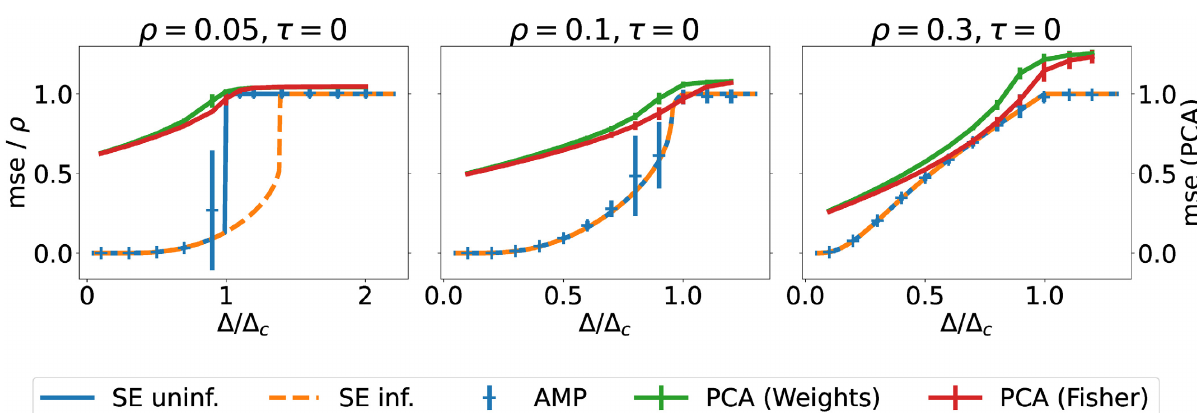
Fig 2. Reconstructing sparse , binary patterns using message passing algorithms and PCA. We plot the mse per pattern obtained by the AMP algorithm, Eq (32), as a function of the effective noise Δ (9), for random (15) and informed (16) initialisations. Lines depict the result of the state evolution, while crosses denote the performance of the AMP algorithm on an instance of the problem. While AMP performs the same starting from both initialisations for ρ = 0.1 and ρ = 0.3, there is a gap in performance for ρ = 0.05, which might hint at the existence of a hard phase (see main text). We also plot the mse of the reconstruction obtained by applying PCA to the weight matrix J and to the Fisher matrix S (31) (green and red, resp.) Parameters: τ = 0. N = 2000 for AMP, N = 20000 for